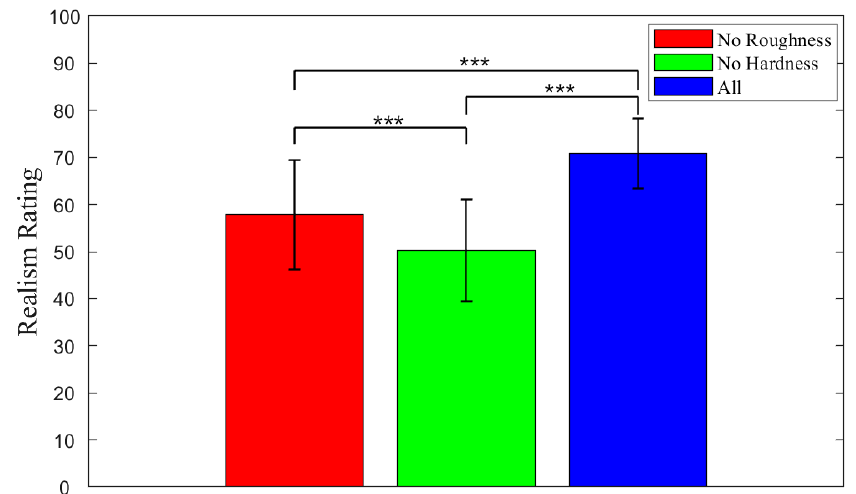
Figure 14. Comparison of realism ratings across the three rendering methods of the eight samples. Statistically significant differences in realism ratings of the three rendering methods are marked with bars and asterisks (*** ≡ p ≤ 0.001 ) .